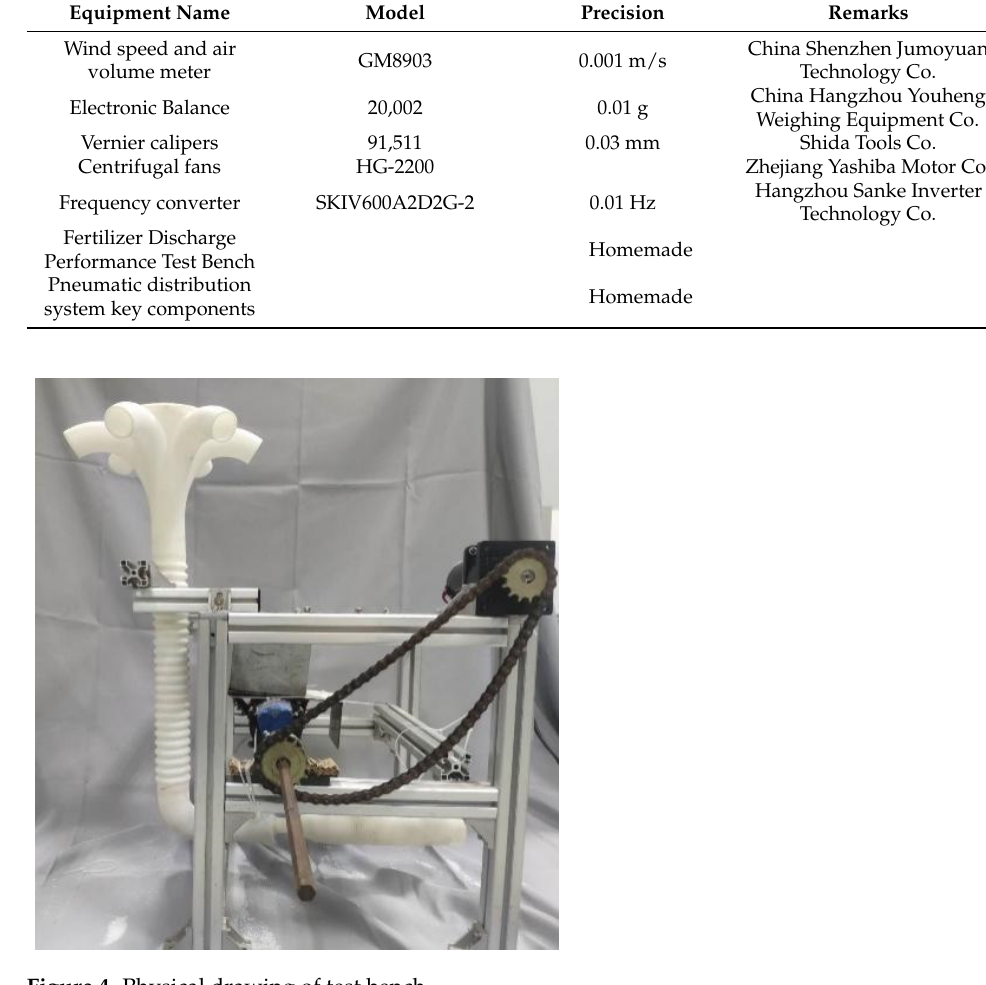
Table 4. Experiment material.